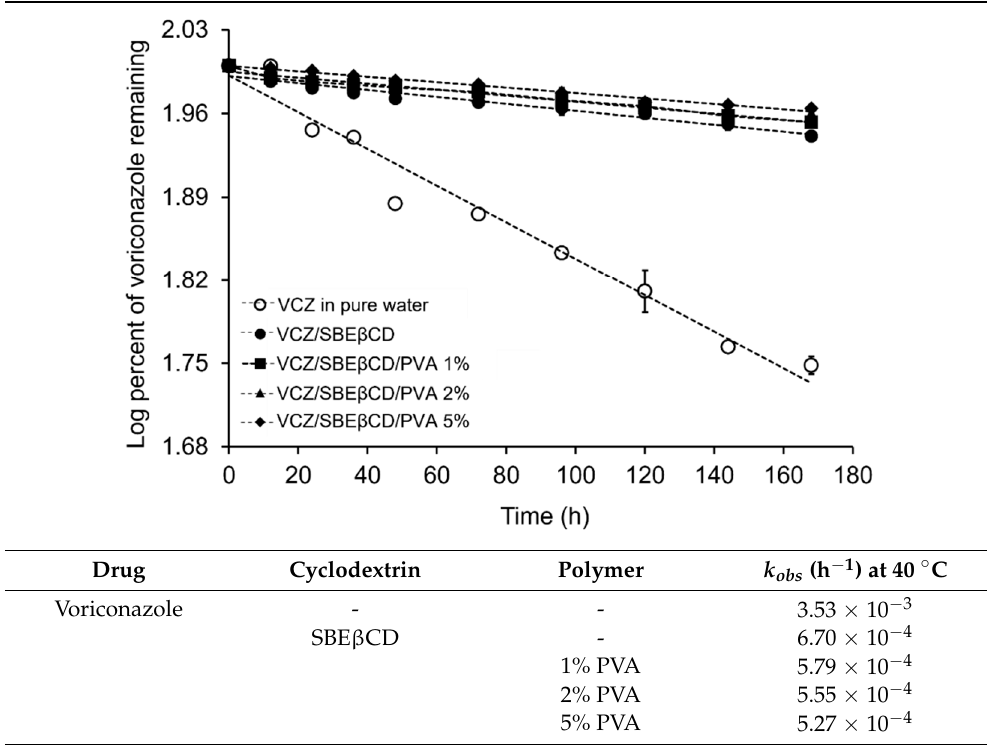
Table 5. Degradation rate constants ( k obs ) of VCZ in pure water and aqueous SBE β CD solutions in the absence and presence of PVA (1, 2 or 5% w/v) under storage temperature at 40 ± 0.5 °C (mean, n = 3).